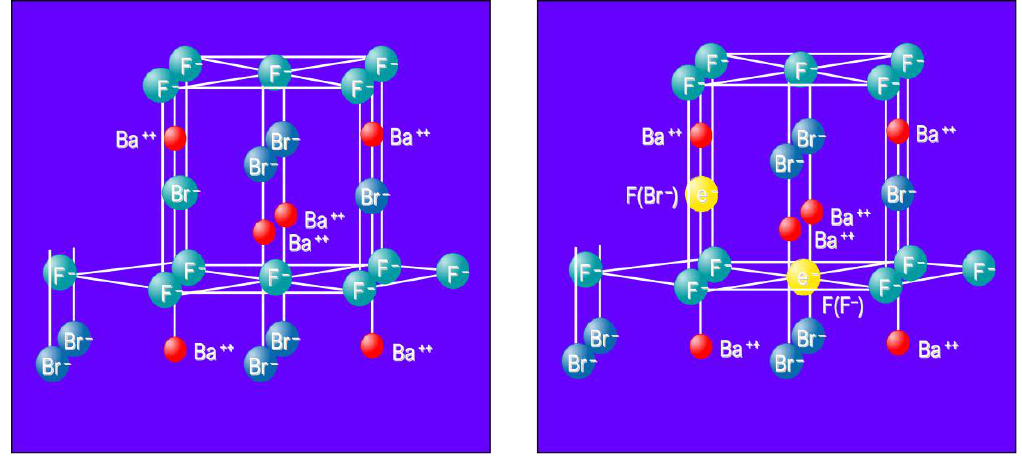
Figure 9. Model of the BaFBr lattice cell ( a ) with F(Br − ) and F(F − ) centers ( b